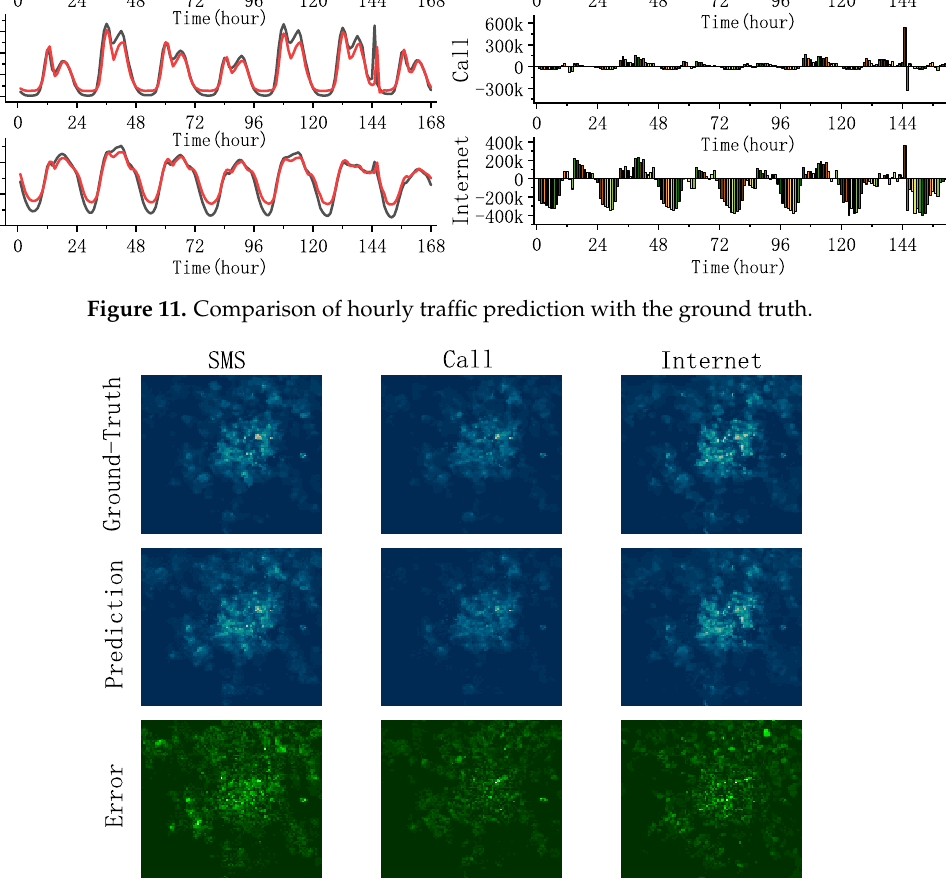
Figure 12. Comparison of predicted and real